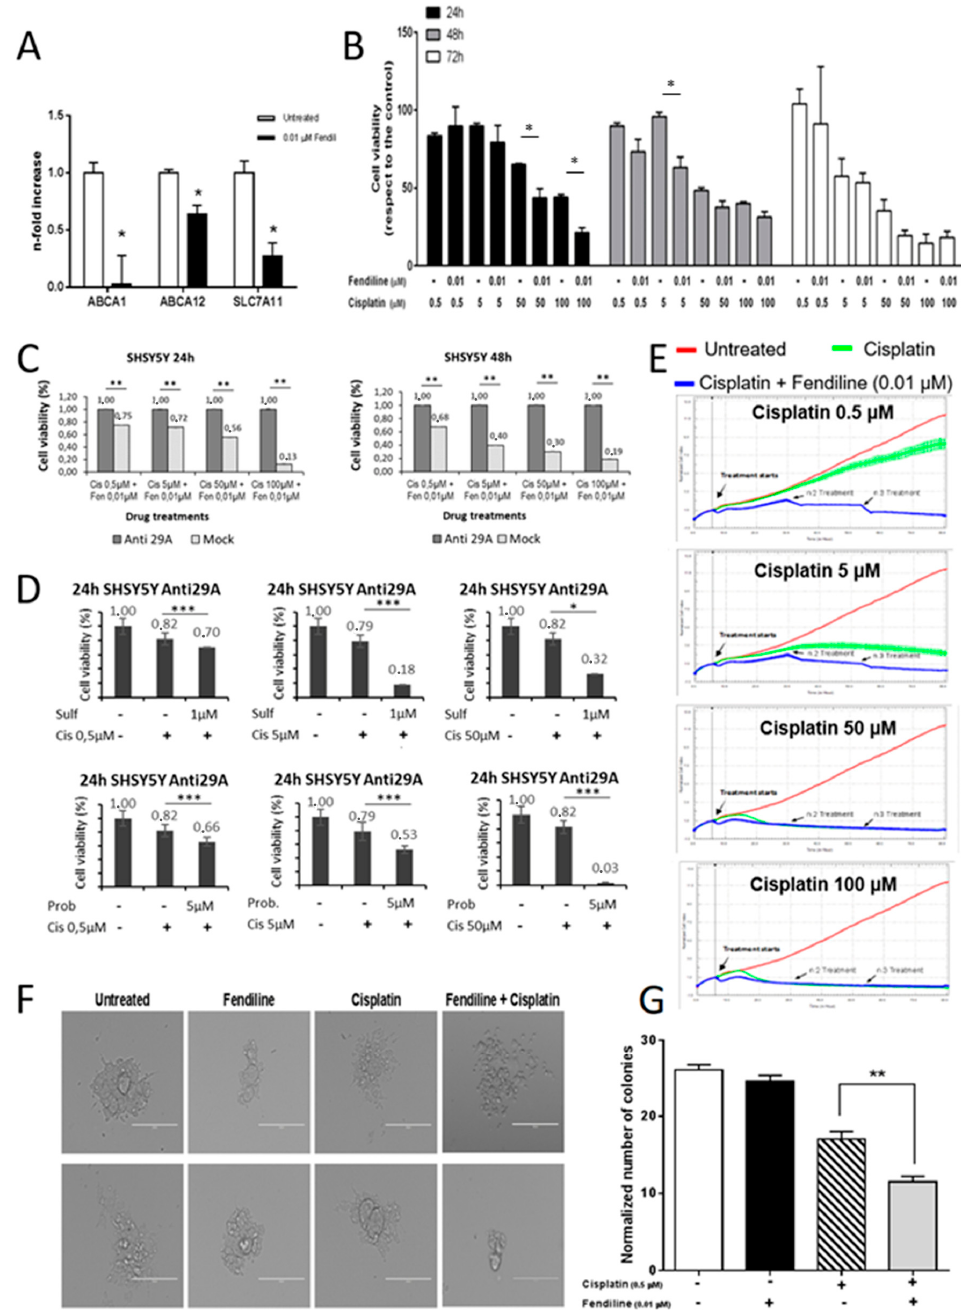
Figure 2. Susceptibility of NB cells to cisplatin is increased by fendiline hydrochloride. ( A ) Real-time RT-PCR quantification of ABC transporters’ mRNA level (ABCA1, ABCA12, and SLC7A11) in wild type SHSY5Y cells, either treated or untreated with 0.01 μ M fendiline for 24 h. Values are reported as the mean ± SD. * indicates p ≤ 0.05, ** indicates p ≤ 0.01; two-tailed Student’s t test was applied. ( B ) Effects of 0.01 μ M fendiline and cisplatin (0.5, 5, 50, 100 μ M) or their combination on SHSY5Y cell viability after 24, 48, and 72 h of treatment, as detected by MTT assay. Values are expressed as the mean ± SD. (*) indicates p < 0.05; two-tailed Student’s t test was performed between the group treated with cisplatin at different concentrations and the group with cisplatin in combination with fendiline. ( C ) Cell viability measured by MTT assay after 24 and 48 h of treatment with cisplatin and Fendiline.